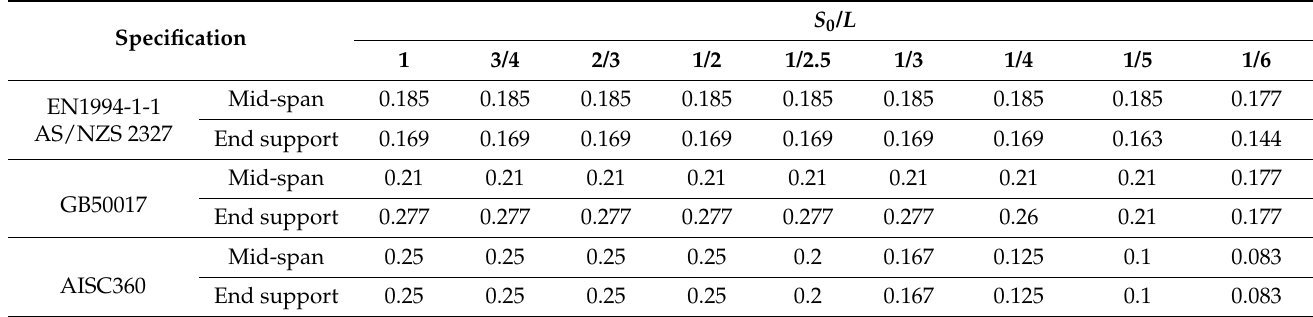
Table 2. The values of b e and L in the positive bending moment region considering b 0 = 0.01 L. Specification